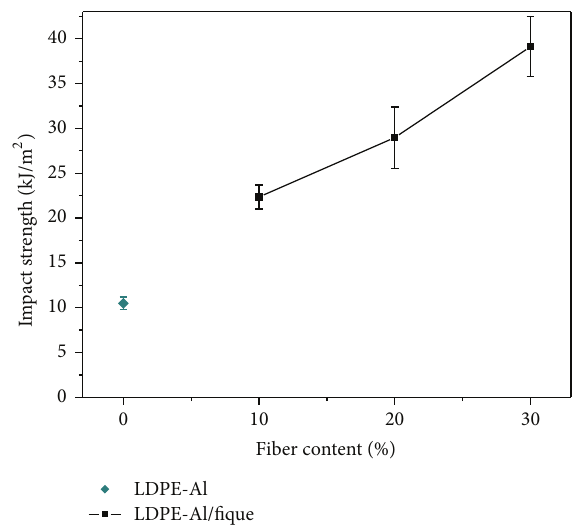
Figure 5: Impact strength of the composite depending on the fiber